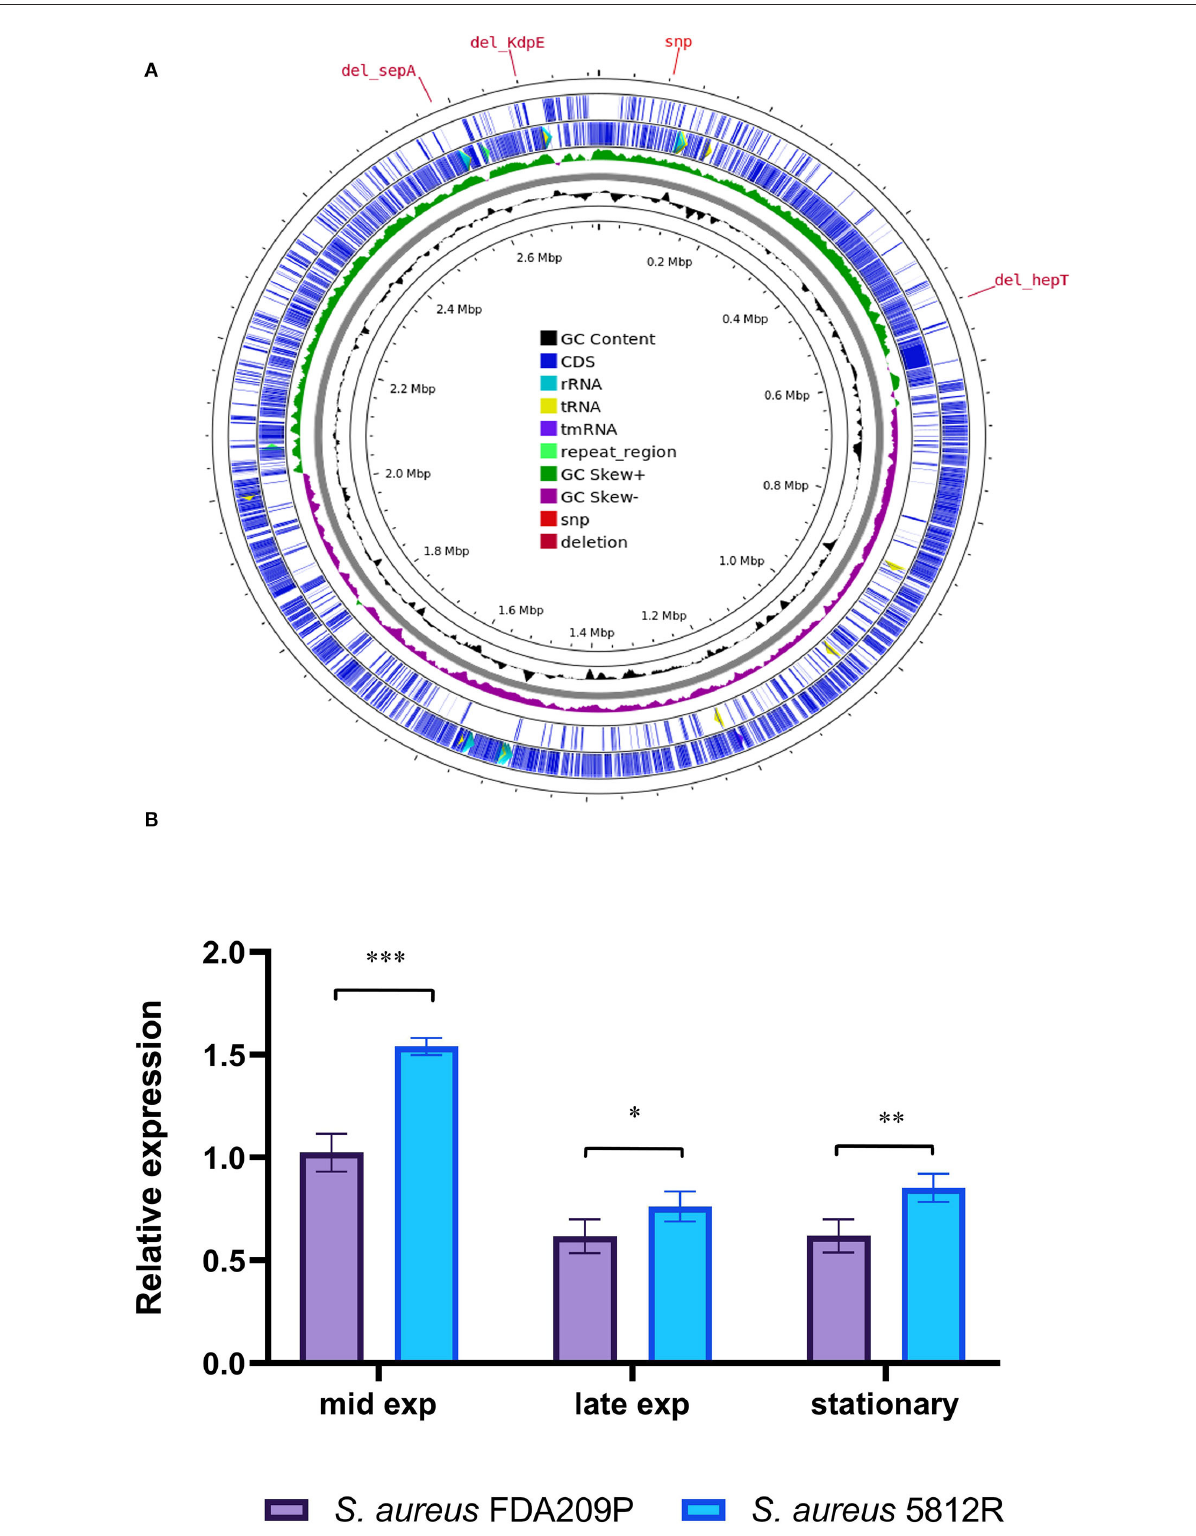
FIGURE4 Graphical circular map of the S. aureus 5812R chromosome (A) . The map was generated using CGView Server (http://cgview.ca/). The expression analysis of gene responsible for the synthesis of cardiolipin ( cls ) (B) . Transcript levels of the analyzed genes were determined by RT-qPCR in relation to the gyrB expression. Mid Exp—the mid-exponential growth phase; Late Exp—the late exponential growth phase; Stationary—the stationary growth phase. The means plus standard deviations of the means of results from three technical replicates are shown (* p < 0.05, ** p < 0.01, *** p <